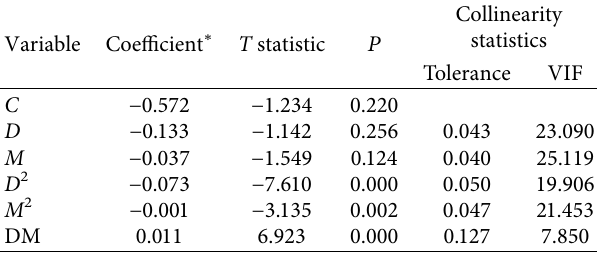
Table 6: Significance of coefficients of the adjusted model (ac-